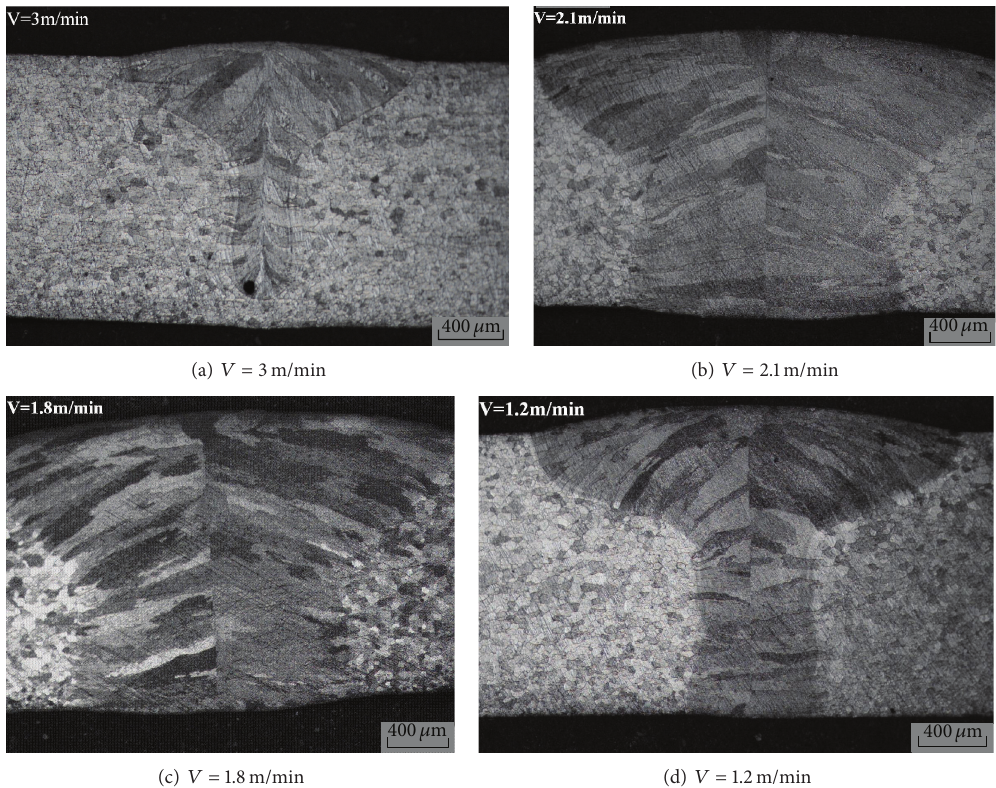
Figure 3: Influence of welding speed on cross-section morphologies of welded seam. ( Δ𝑍 = 0 mm; 𝑃 = 1.5 kW; 𝑈 𝑓 = 15 L/min).